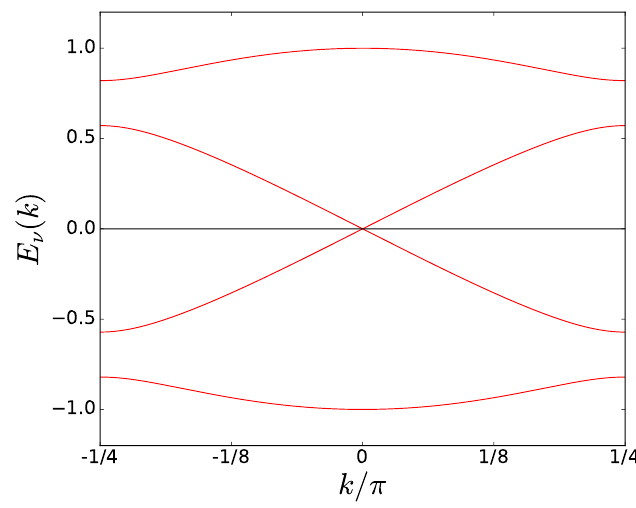
Figure 7: Band structure of the 2-gap Ansatz for N = 4: the bands have now two gaps. The gap at E = 0 is closed (compare with Fig.